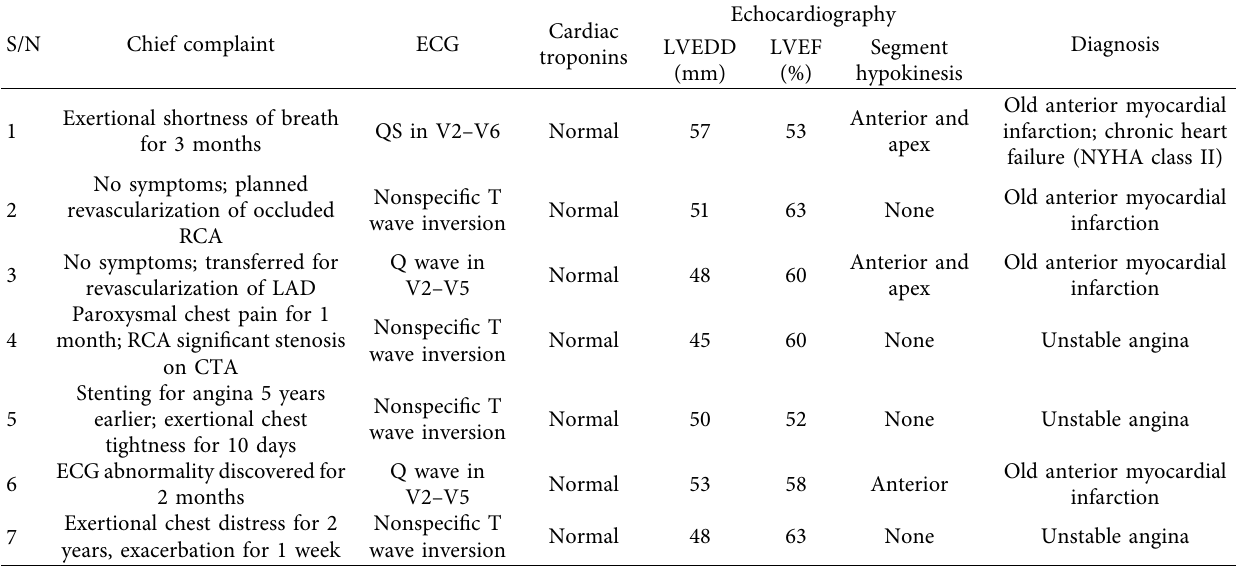
Table 2: Baseline clinical information of the index